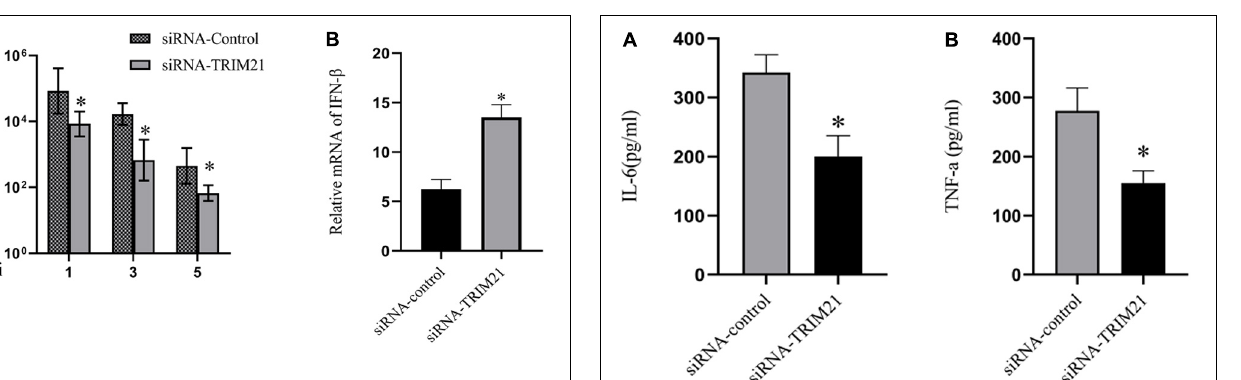
FIGURE 3 | Silencing TRIM21 controls HSV-1 replication in HSV epithelial keratitis. (A) Viral titers in tear films from siRNA-TRIM21 and siRNA-control treatment mice were determined by TCID 50 assay on days 1, 3, and 5 post-infection. (B) The relative mRNA level of IFN- β in corneas from each group measured by qPCR. n = 3 per group. Data are shown as mean ± SD of three independent experiments. ∗ P < 0.05.